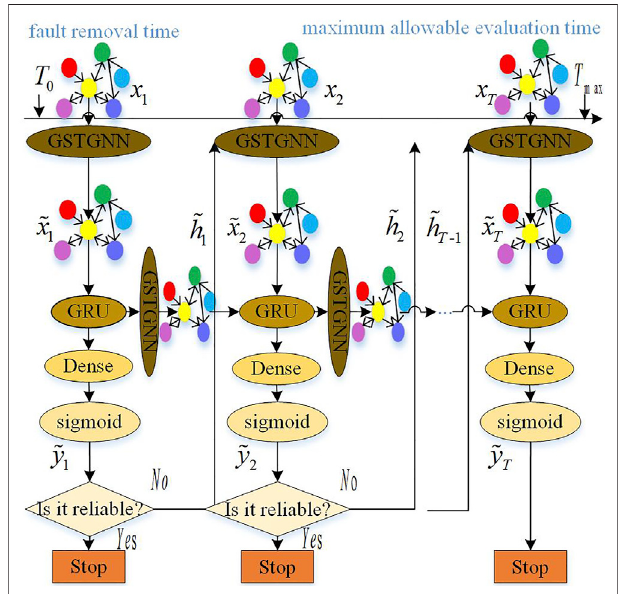
FIGURE 3 | Adaptive TSA process.